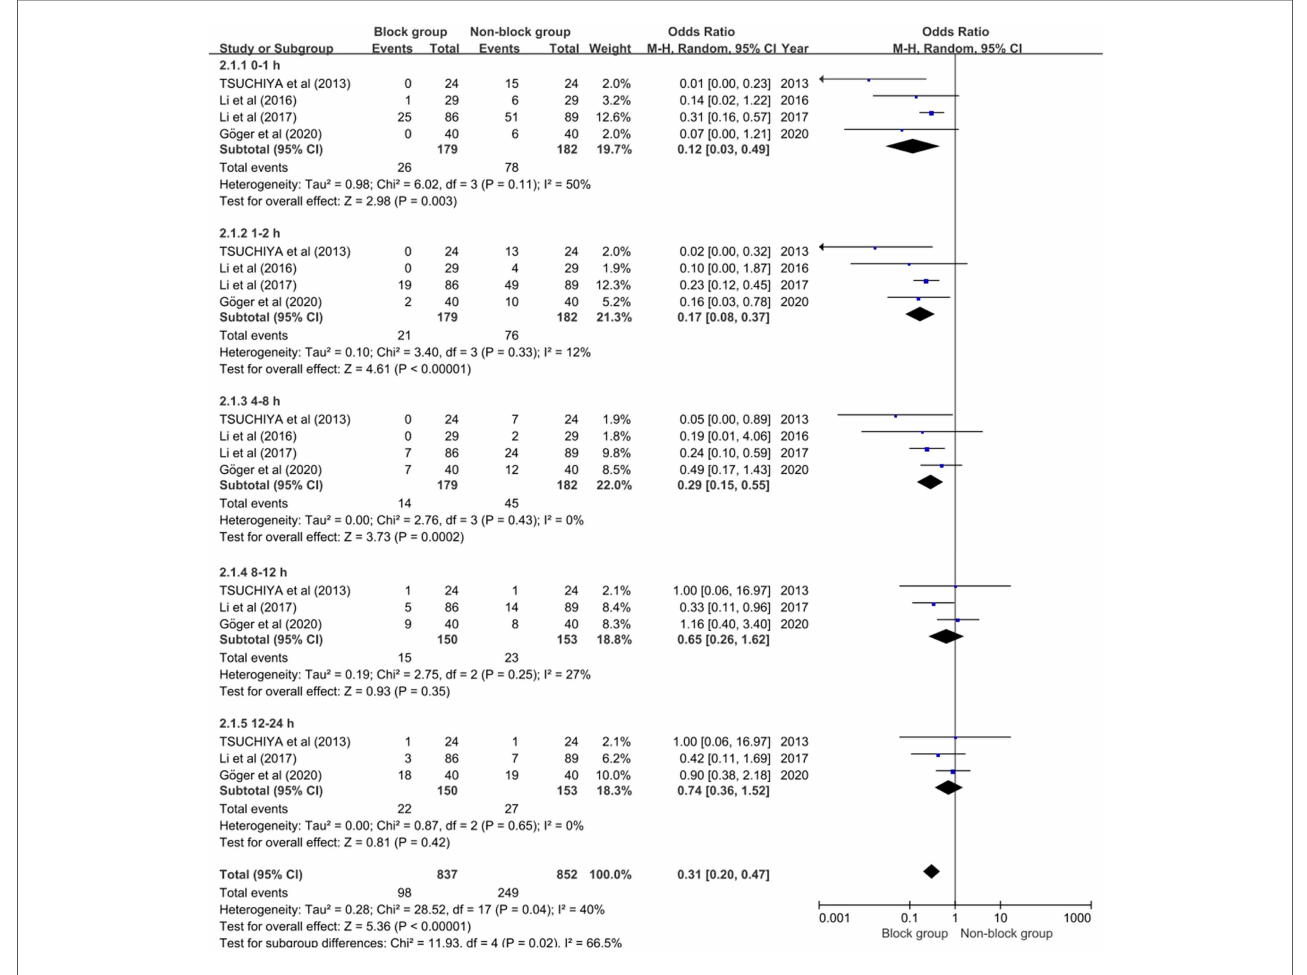
FIGURE 4 Forest plot illustrating the incidence of moderate to severe